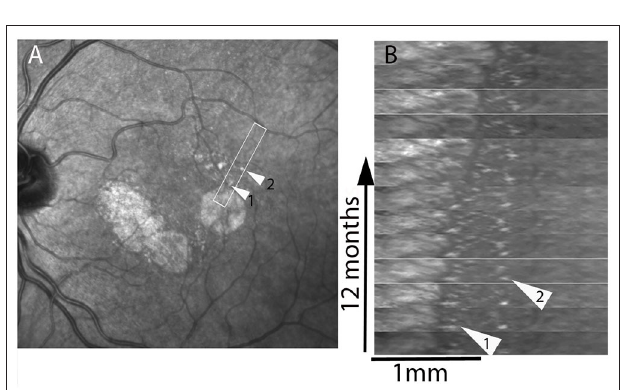
FIGURE 4 | Case 4. Spatiotemporal (xt) plot. Images from regions of interest ( boxed in A) were registered and rotated in (B) in order to display the progression from left to right; the x axis represents distance, the y axis time. Arrowheads show two hyperreflective spots that are followed-up. Note the deviation from verticality of the virtual line joining the successive positions of the hyperreflective spot shown by arrowhead 2, which is initially located 620 µ m away from the margins. See also Supplementary Video 3